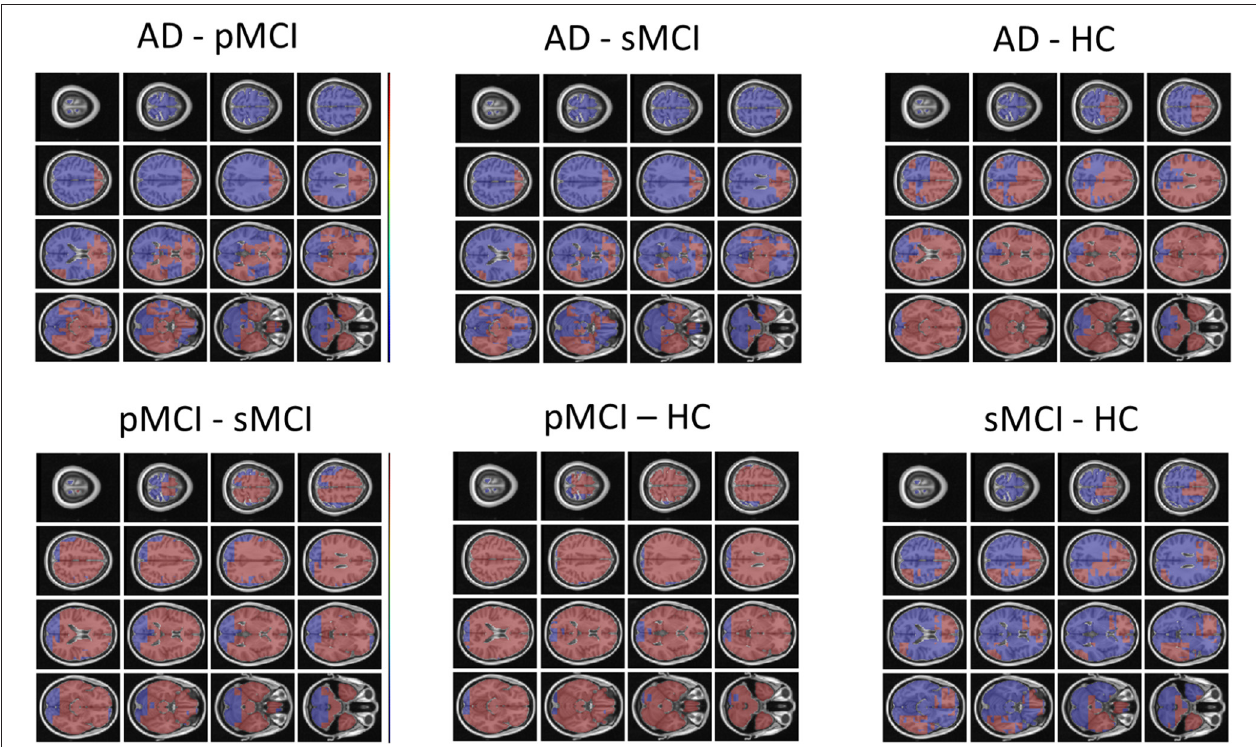
FIGURE 9 | FSL Randomise maps for different combinations of clinical groups in cross-sectional OASIS3 using voxel-level brain-age predictions. Red coloured voxels indicate a significant statistical t -test after correcting for multiple comparisons. Blue regions were not significant after correction. HC, Healthy Controls; pMCI, progressive MCI; sMCI, stable MCI; AD, Alzheimer’s